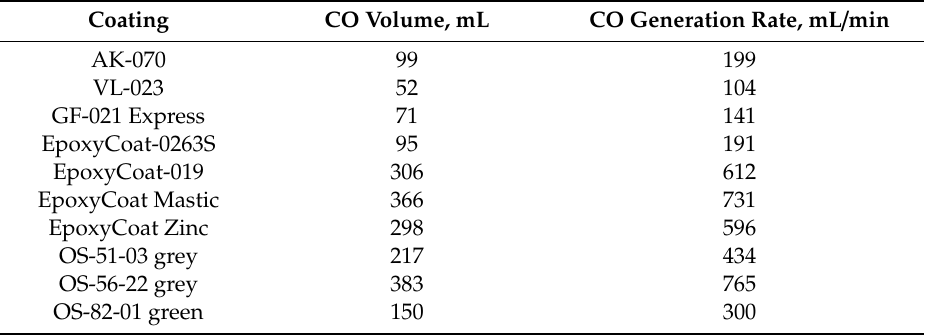
Table 5. Volume of the generated CO from the coatings’ breakdown